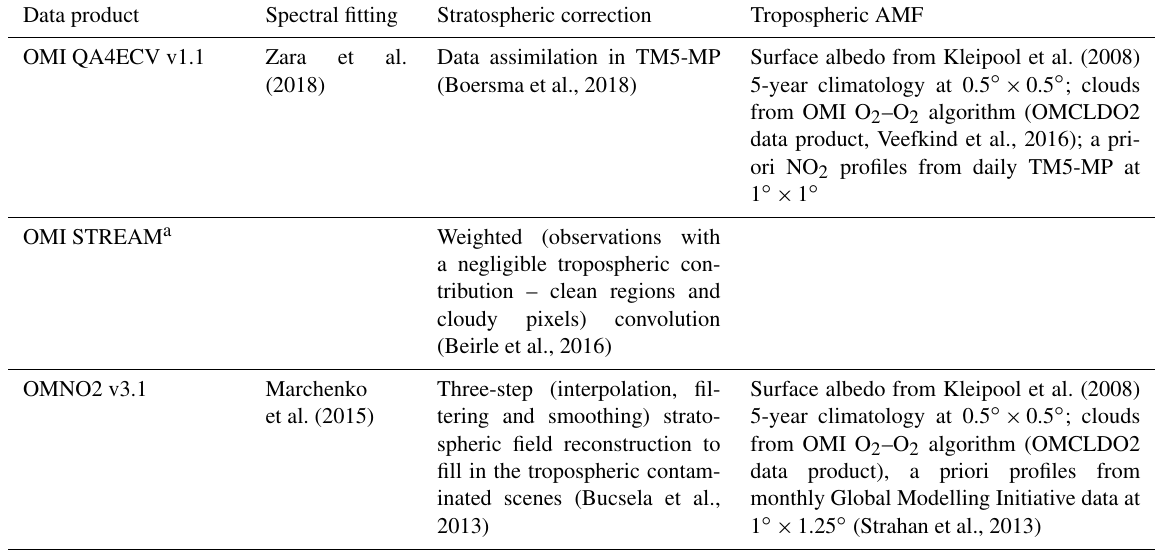
Table 1. The OMI satellite data products considered in this work.